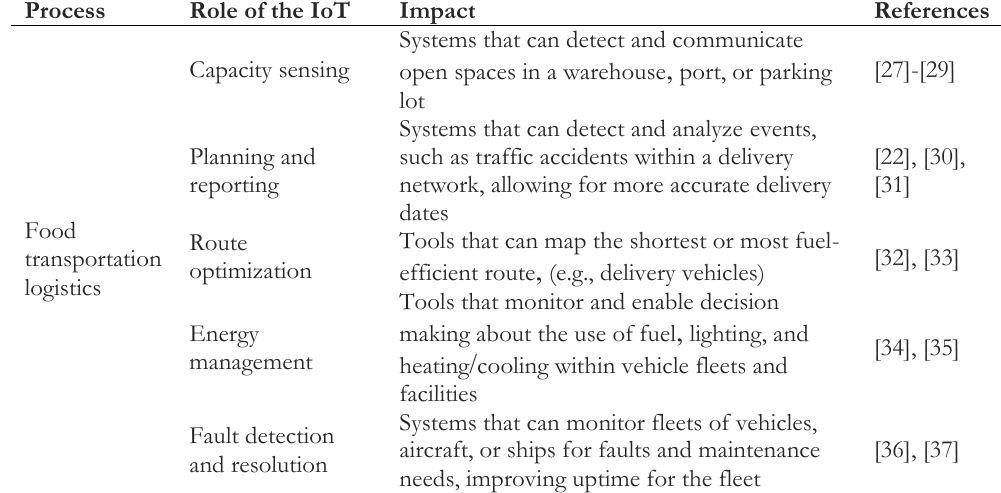
Table 4. Application of the IoT in food transportation procurement in the food supply chain.